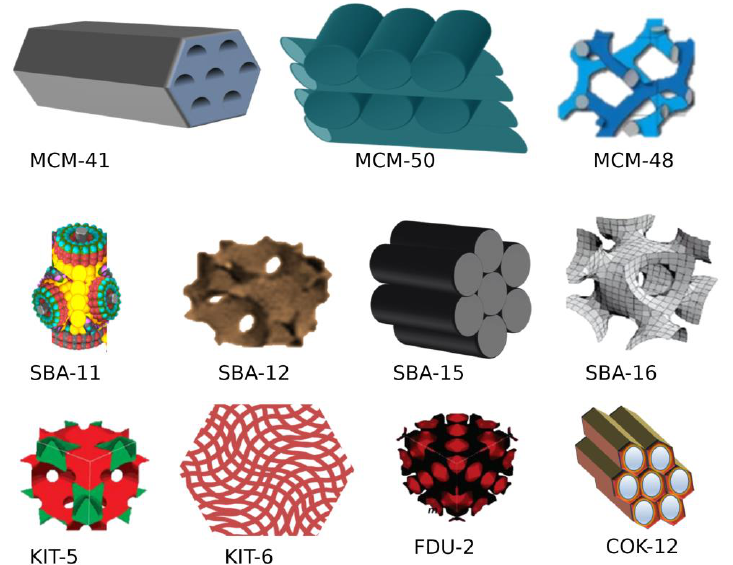
Figure 3. Types of mesoporous silica based on shape and morphology. (Figure created using BioRender.com; accessed on 2 December 2022). Table 1. Types of MSN used for drug delivery applications.